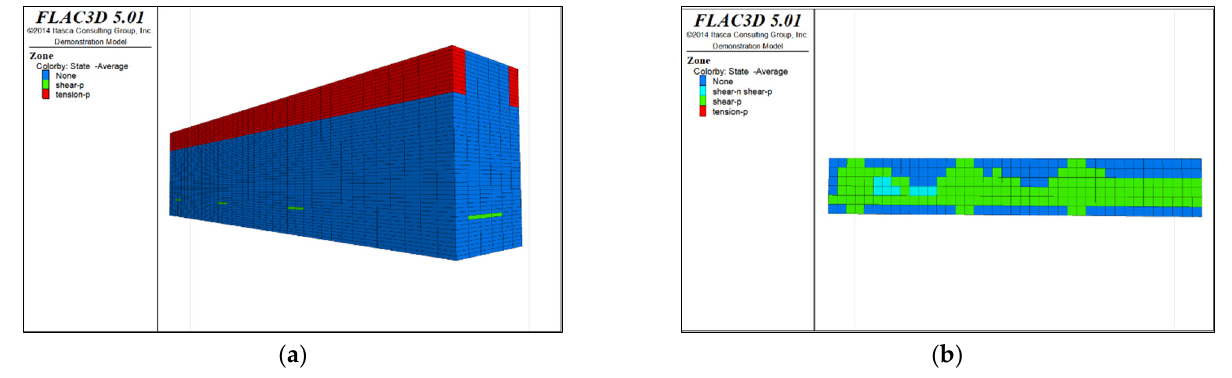
Figure 6. Distribution of plastic zones in the roof protection layer under Scheme B. ( a ) 3D drawing. ( b ) plan of roof protection layer.